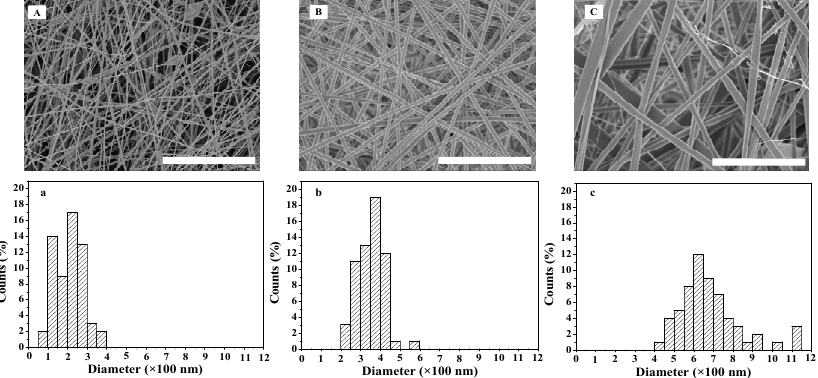
Figure 1. SEM images and diameter distribution of ASF fibers at different electrospinning concentrations: ( A , a ) 7 wt %; ( B , b ) 8 wt %; ( C , c ) 9 wt %. Scale bars: 10 μ m.